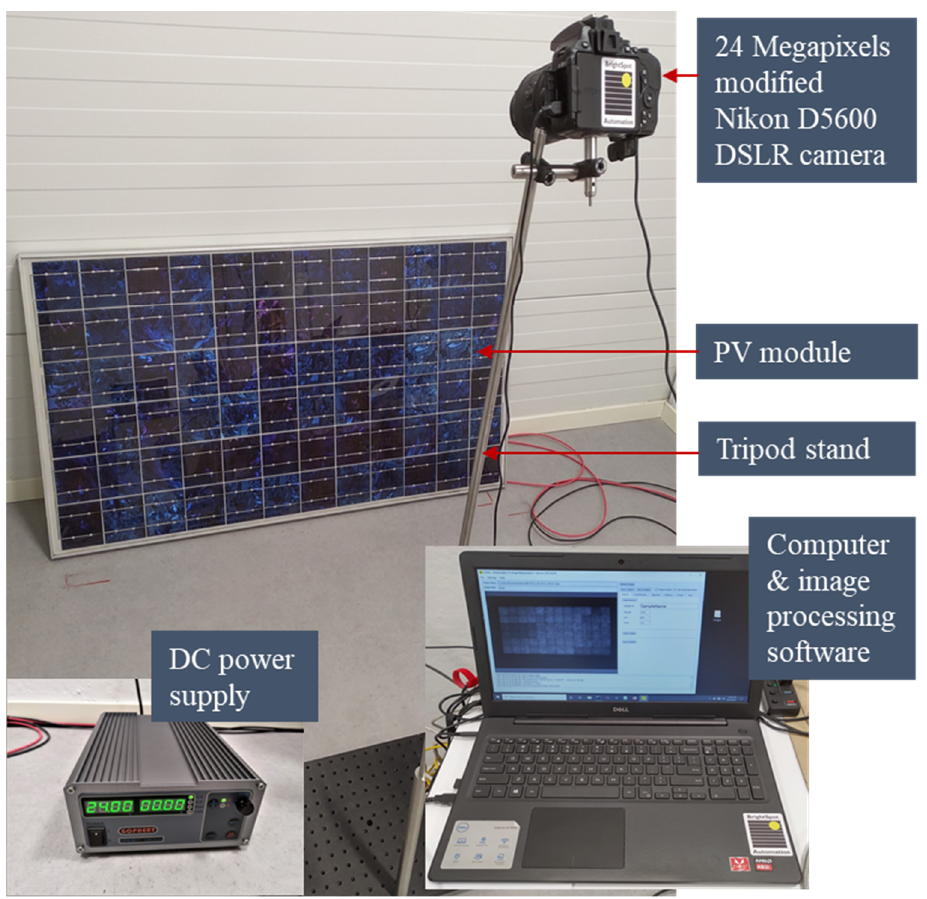
Figure 2. Experimental setup of the EL imaging system. The system runs on a DC power supply.